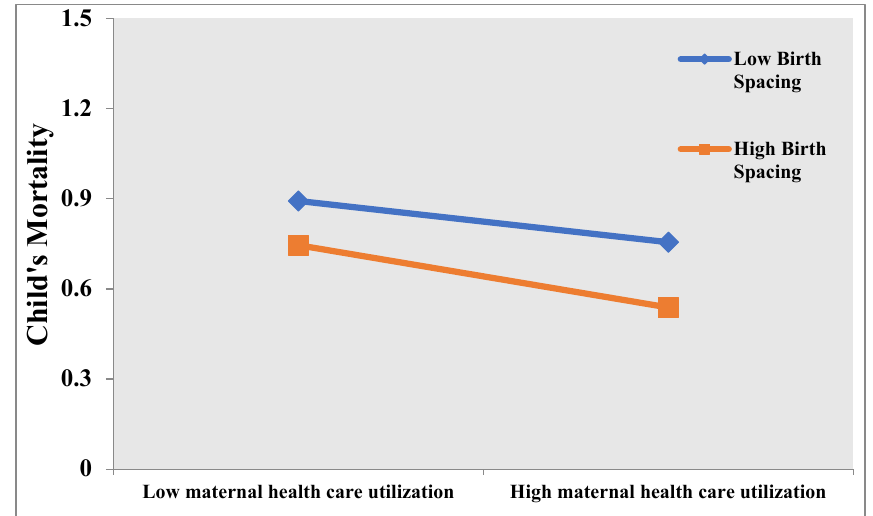
Figure 1. Interaction E ff ect of Birth Spacing and MHCS on Child Mortality.